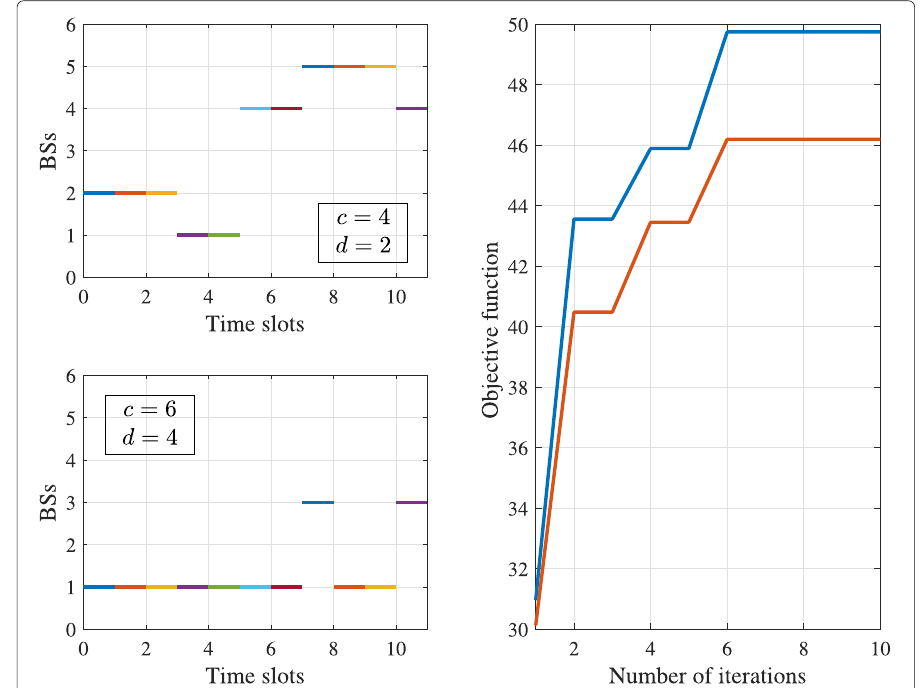
Fig. 6 BS-VS association with given power during T and the tradeoff between the optimization objective and low-switch by setting c and